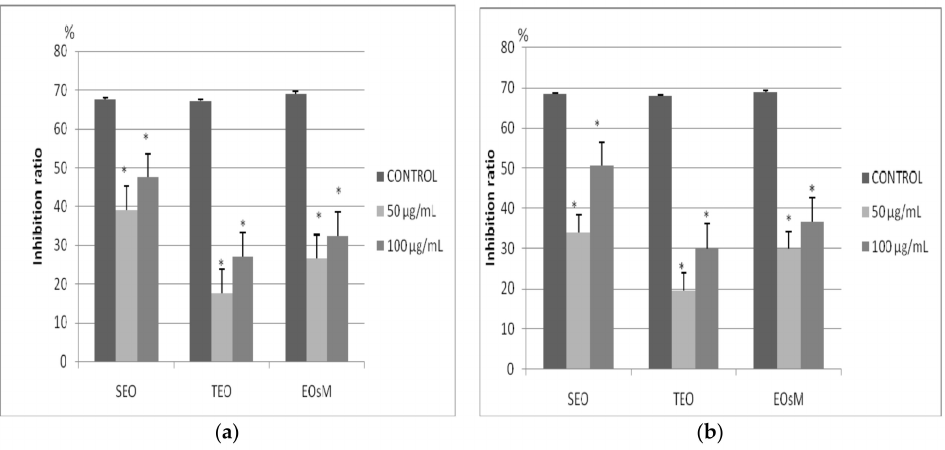
Figure 1. Antiproliferative activity of Salvia officinalis essential oil (SEO), Thymus vulgaris essential oil (TEO) and their essential oils mixture (EOsM) ( a ) for A375 human melanoma cell line; ( b ) for B164A5 mouse melanoma cell line: * the value is significant different versus control at p <